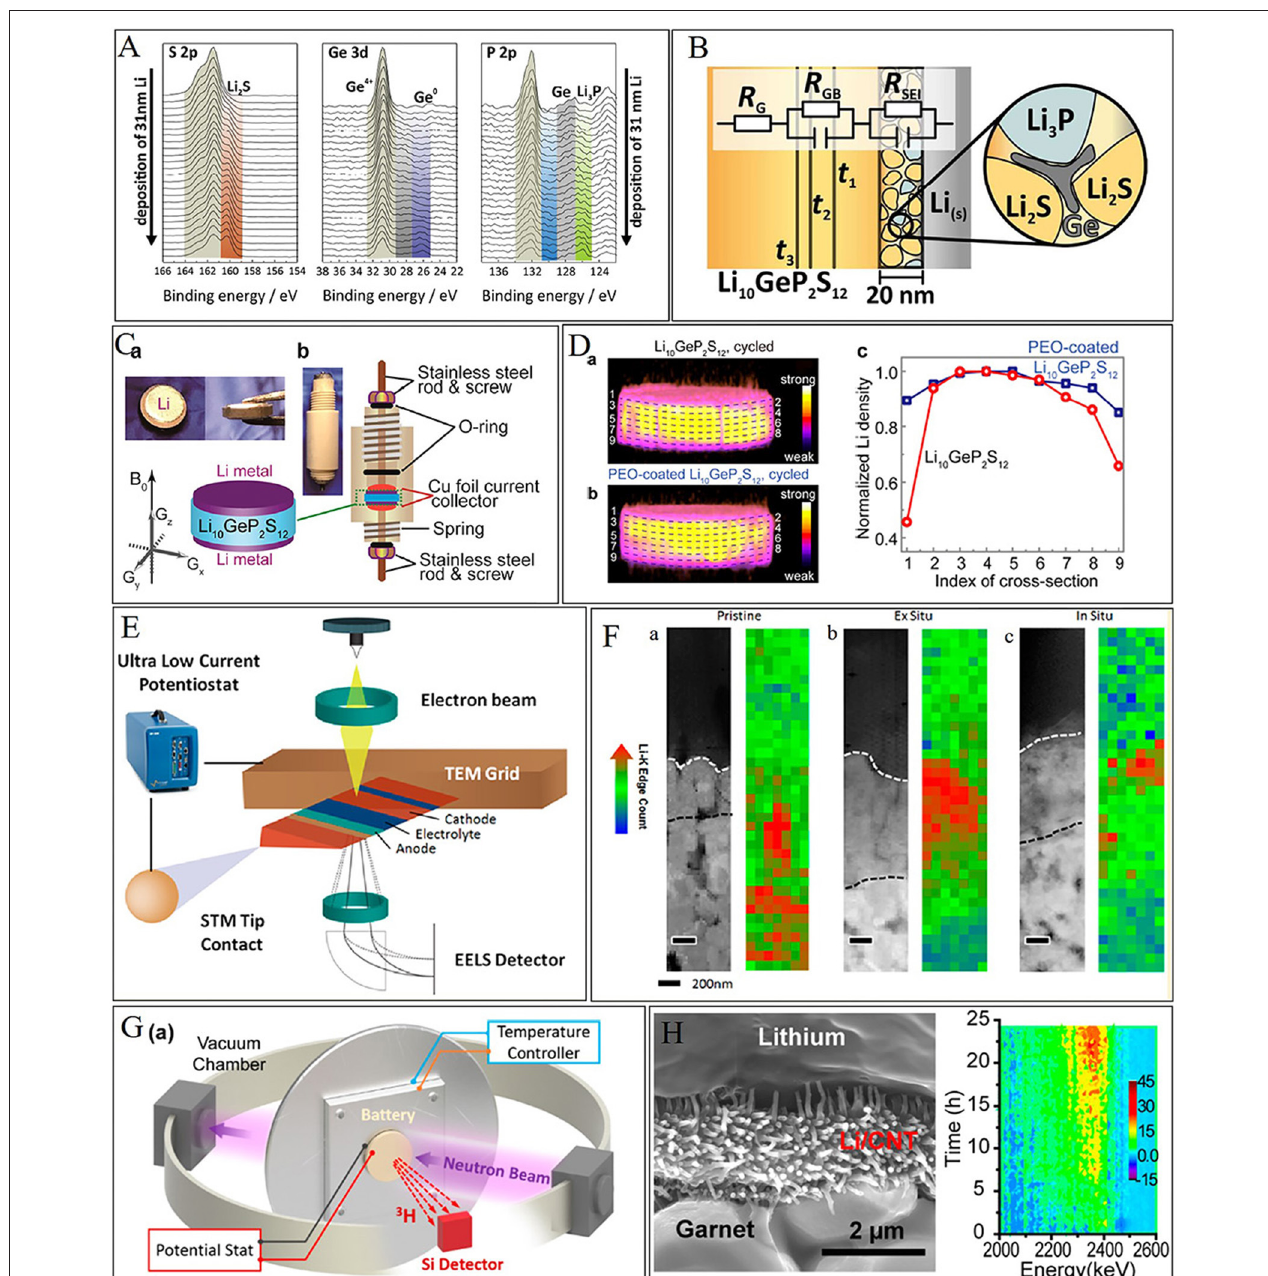
FIGURE 9 | In situ characterization techniques for solid-solid interface stability. (A) in situ XPS recorded during deposition of Li metal on LGPS. With increasing Li deposition time, LGPS decomposes. (B) Schematic of the interphase formation at the Li/LGPS interface according to the XPS result. [Reprinted with permission from (Wenzel et al., 2016). Copyright (2016) American Chemical Society]. (C) Pictures and schematic of a cylindrical cell for MRI. (D) Li density profiles at different depths of electrochemically cycled LGPS pellets. [Reprinted with permission from (Chien et al., 2018). Copyright (2018) American Chemical Society]. (E) Schematic of in situ TEM biasing of nanobattery. (F) STEM image and EELS characterization. (a–c) HAADF image of the nanobattery stack along with Li K-edge concentration mapping of (a) pristine, (b) ex situ , and (c) in situ samples with scale bar represents 200nm. [Reprinted with permission from Wang et al. (2016b). Copyright (2016) American Chemical Society]. (G) Schematic of the NDP system. (H) 2D projection of the NDP spectra collected at 5min intervals during cycling. [Reprinted with permission from (Wang et al., 2017a). Copyright (2017) American Chemical Society].